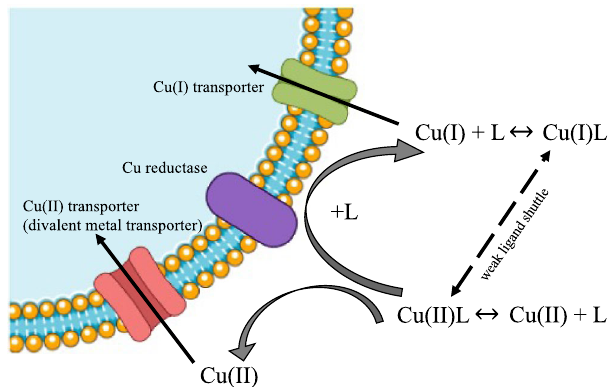
Fig. 2 Copper uptake mechanisms in the marine environment. Known mechanisms of copper uptake associated with organic copper-binding ligands in the marine environment by